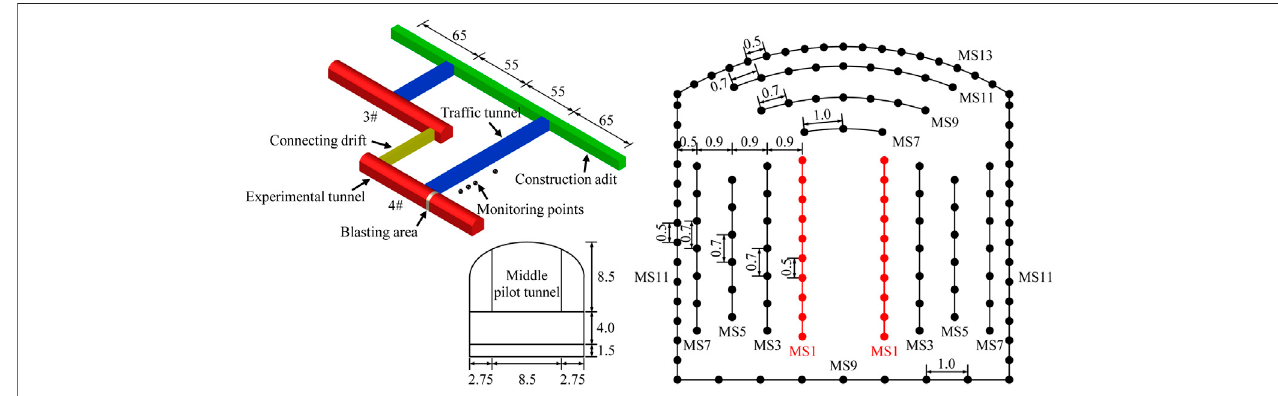
FIGURE 7 | Blasting design of the pilot tunnel and the arrangement of the vibration